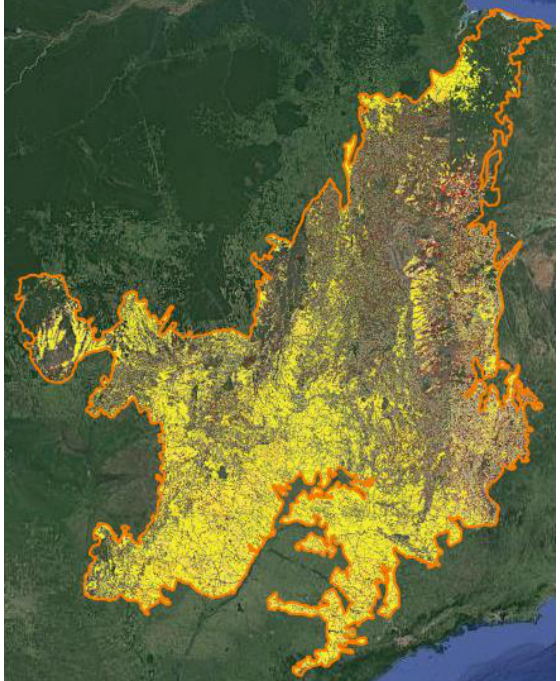
Figure 4. Deforested area until 2018 (yellow polygons) in the Cerrado (orange line) Source: Terrabrasilis